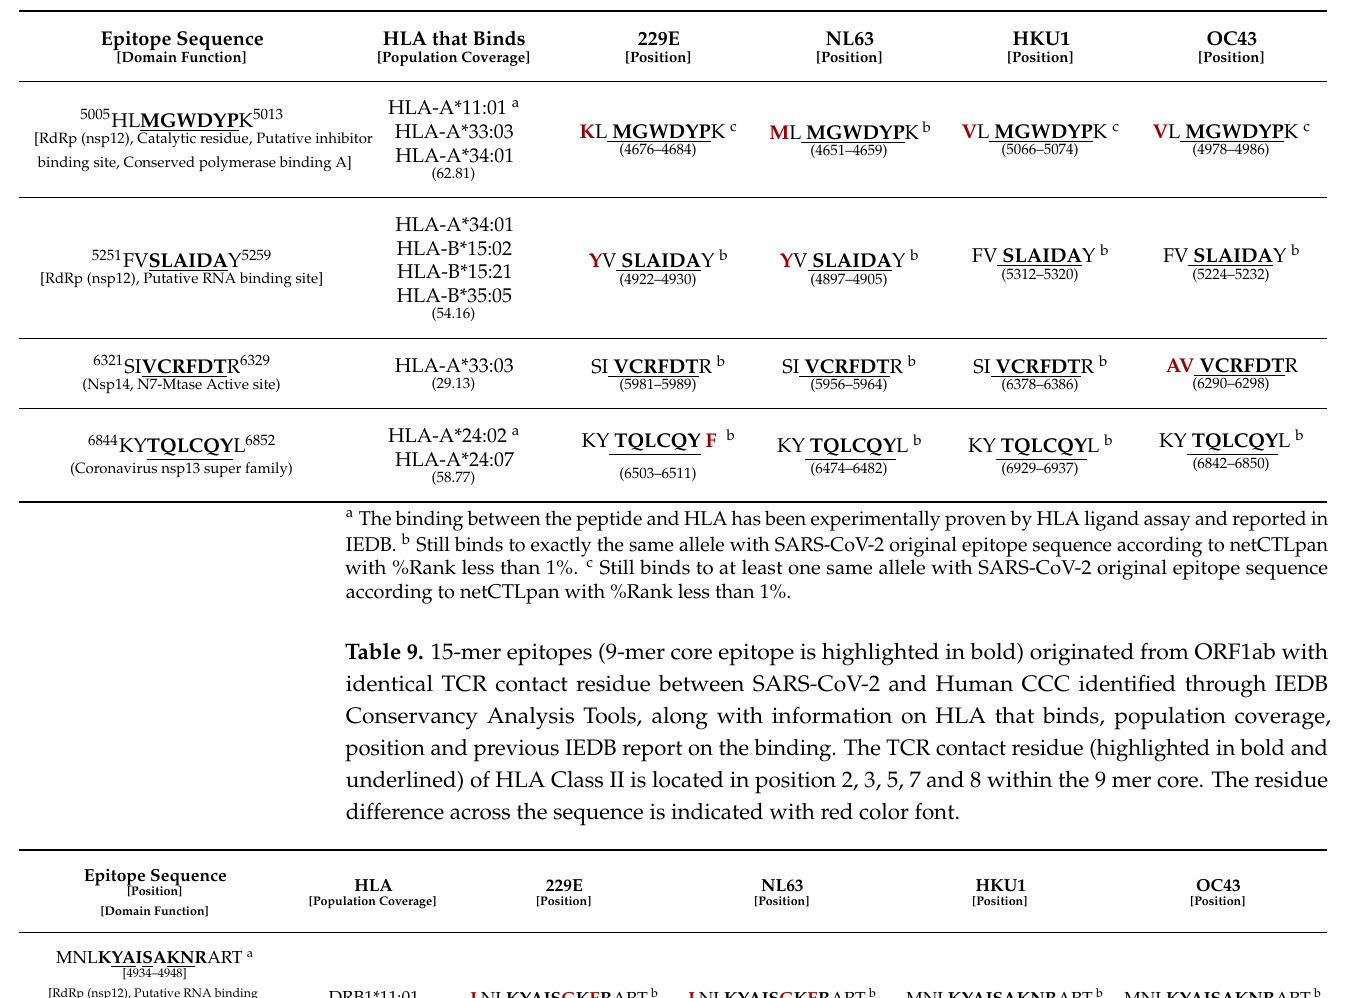
Table 8. 9-mer epitopes originated from OR1ab with identical TCR contact residues between SARS- CoV-2 and Human CCC identified through IEDB Conservancy Analysis Tools, along with information on HLA that binds, population coverage, position and previous IEDB reports on the binding. The TCR contact residue of HLA Class I is located in position 3–8 (marked by underlined). The residue difference across the sequence is indicated with red color text.